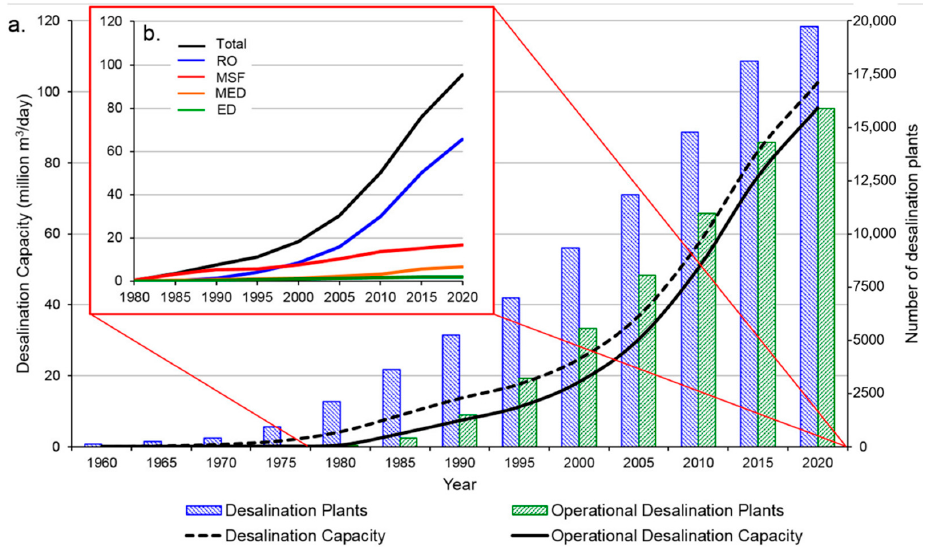
Figure 1. ( a ) Evolution of desalination capacity and the number of plants across the world over the past 60 years. Inset: ( b ) comparison of the desalination capacity evolution for four main desalination technologies since 1980 [3].